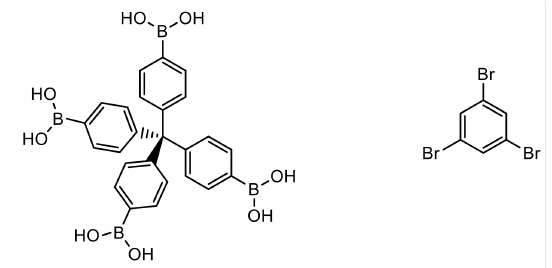
Figure 8. Structures of PAF-111 building blocks.